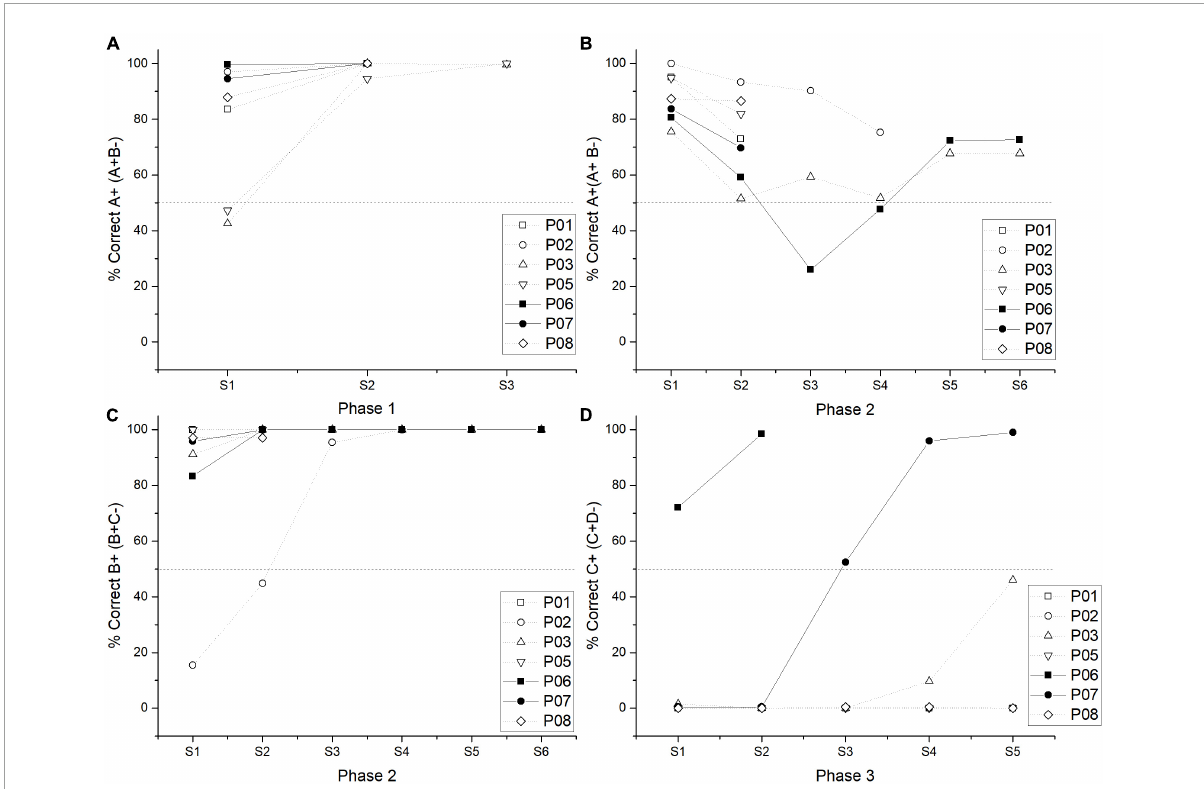
FIGURE1 Individual performance in the percentage of correct responses by a session in phase 1 (A) , phase 2 for A + stimulus (B) , phase 2 for B + (C) , and phase 3 (D) . Pigeons P06 and P07 were plotted in a straight line since these were the only ones who reached the criterion during phase